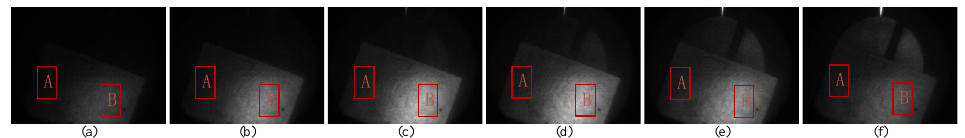
Figure 4. Intensity images acquired by ICCD with delay time: ( a ) 240 ns, ( b ) 243 ns, ( c ) 246 ns, ( d ) 249 ns, ( e ) 252 ns, ( f ) 255 ns, respectively. Region A is from I